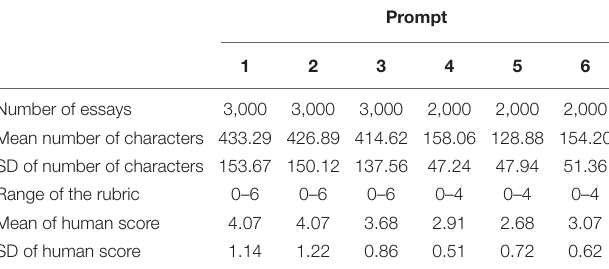
TABLE 1 | The characteristics of the datasets from the six essay